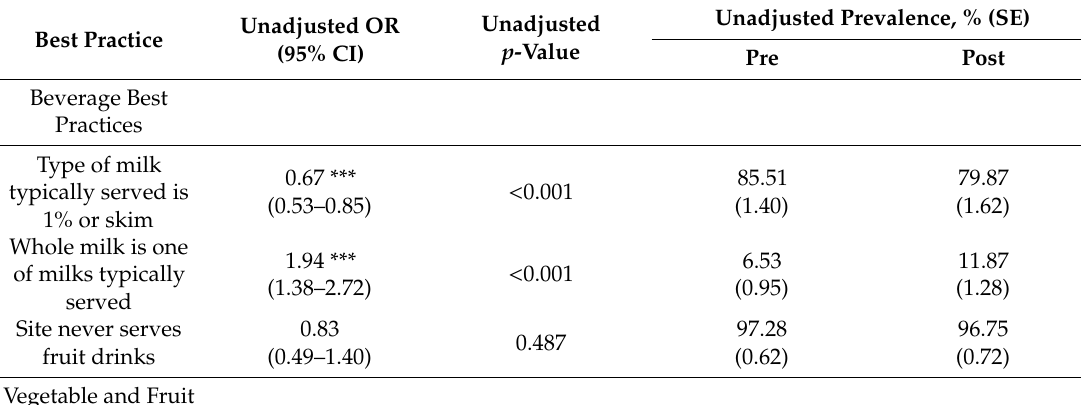
Table A3. Progress in meeting selected CACFP best practices (unadjusted models),